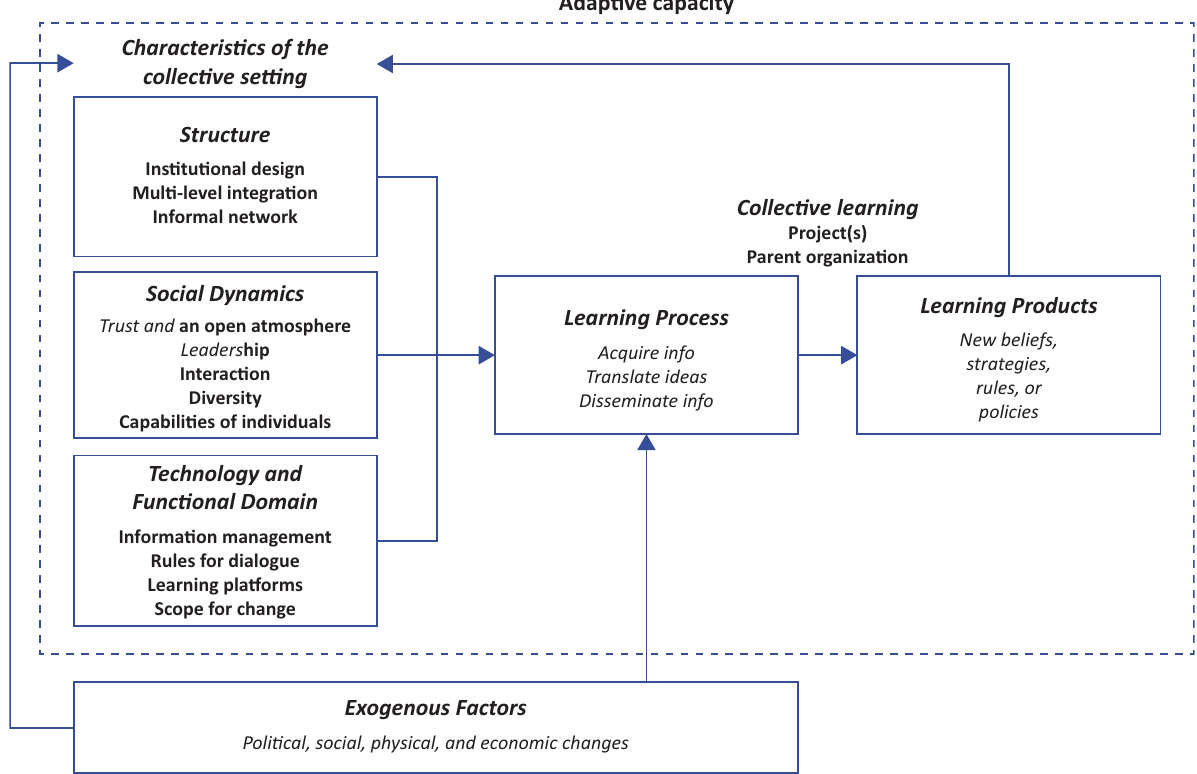
Figure 1. Framework of collective learning (adapted from Gerlak & Heikkila,